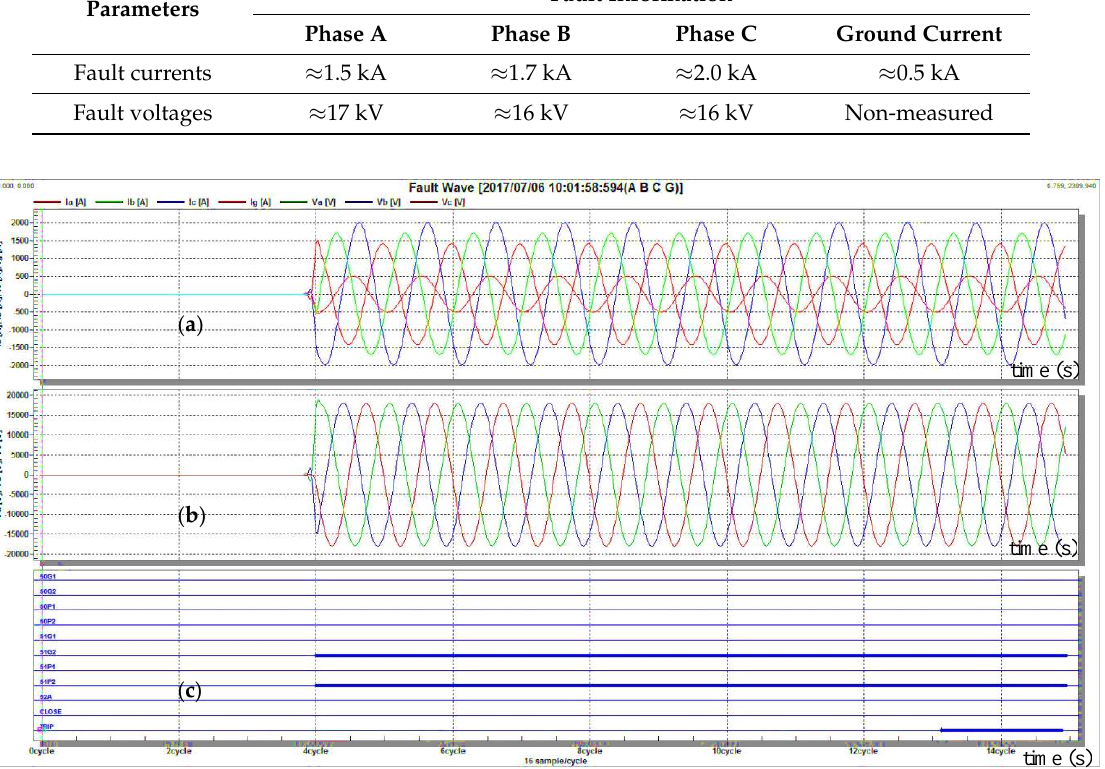
Table 19. Information of fault corresponding to the three phase to ground fault F3 at 473 Go Noi feeder.